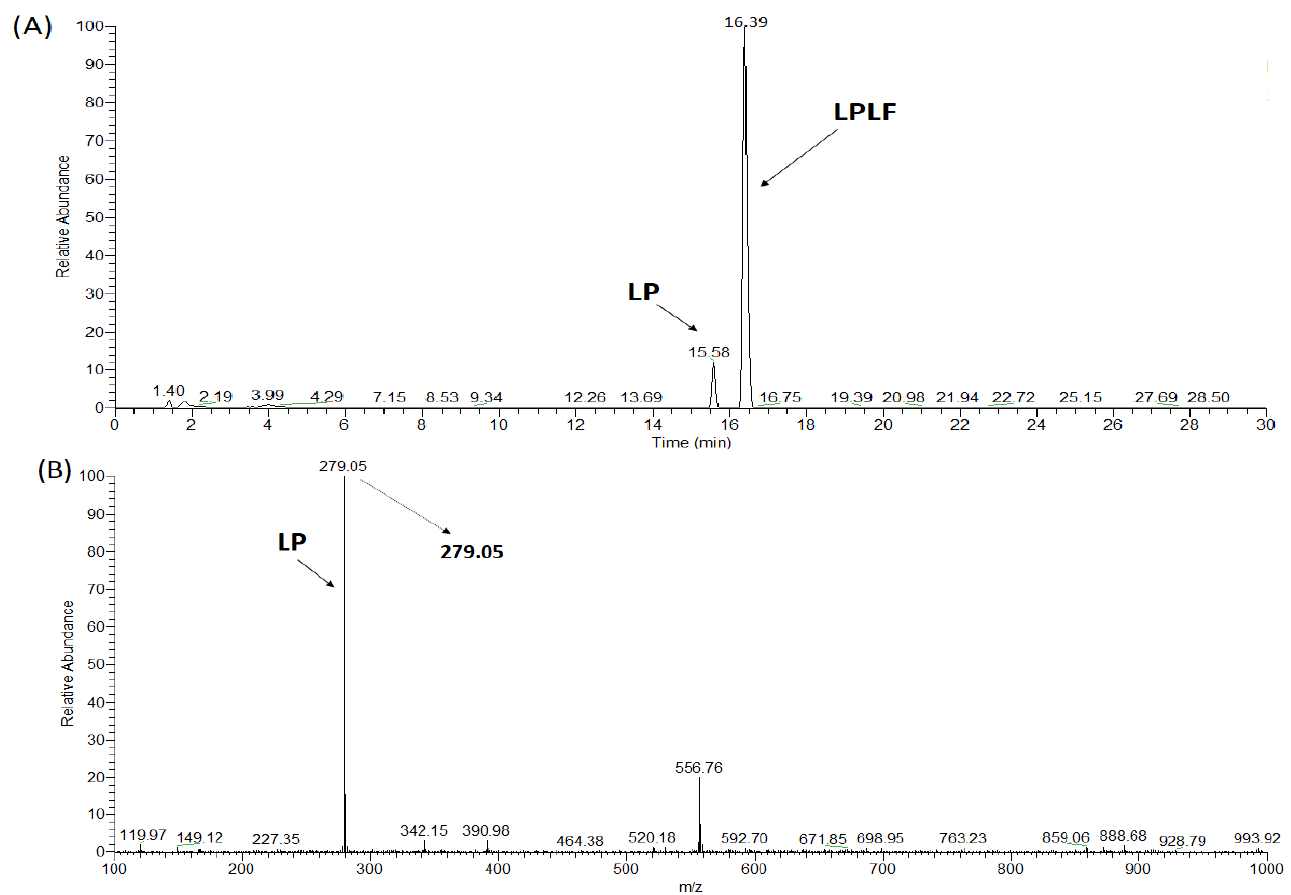
Figure A3. The stability of LPLF against the ACE activity under the pre ‐ incubation condition with ACE. ( A ) LC ‐ MS profile of LPLF. ( B ) The MS spectrum of fragment LF (m/z 279.05).